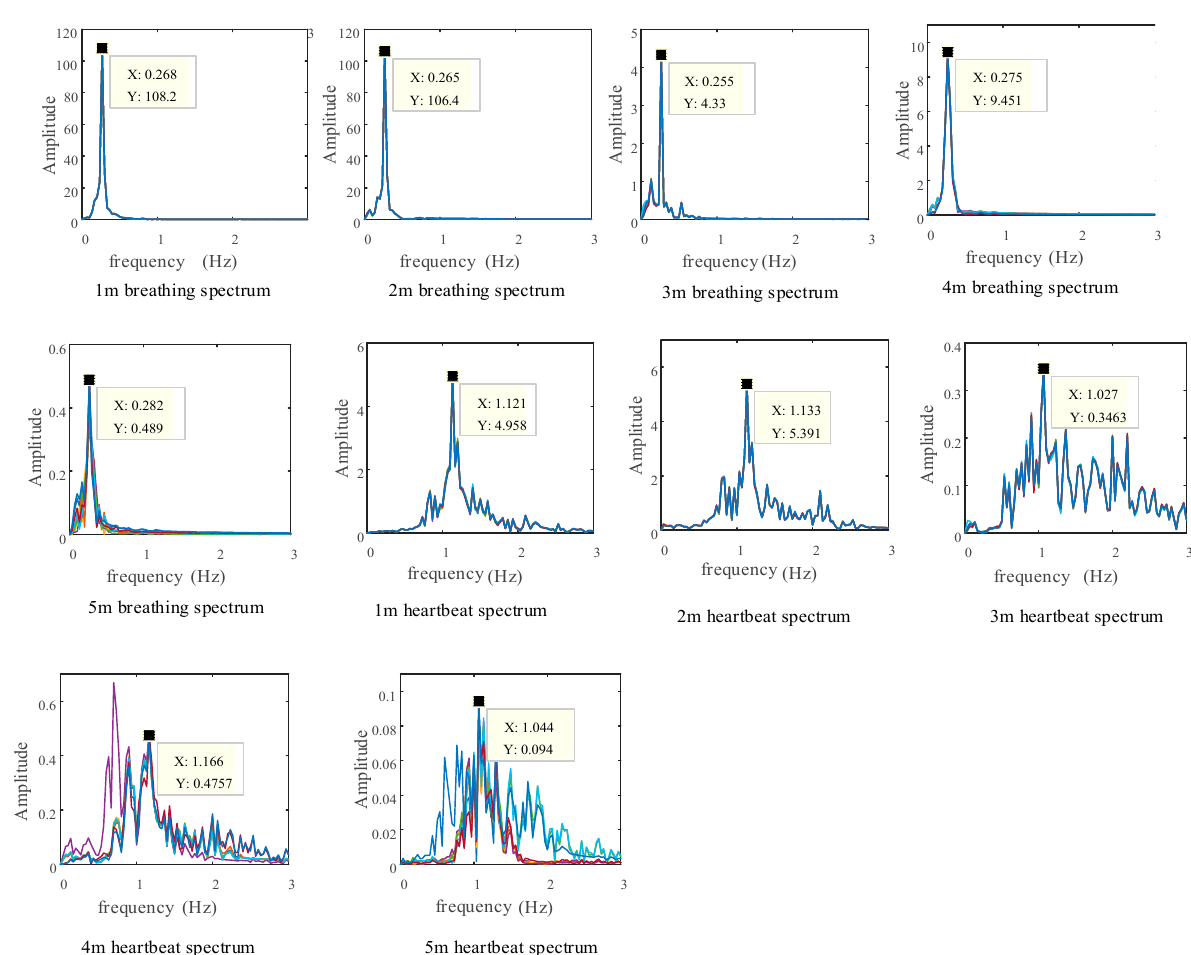
Figure 14. Actual measured spectrum. Table 4. Actual scene distance test